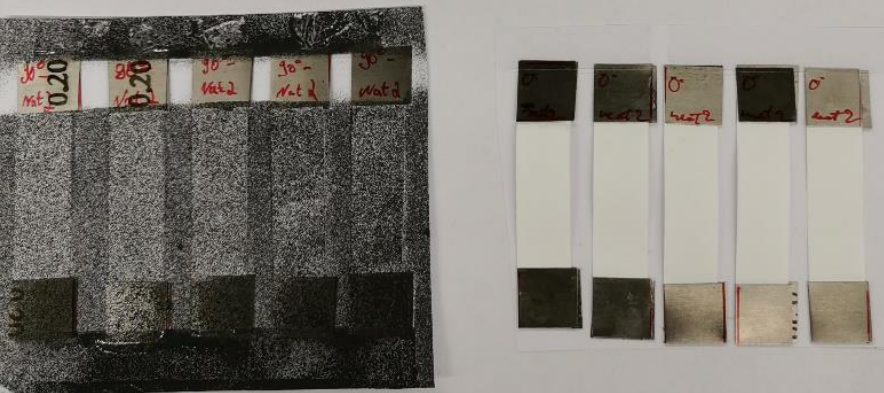
Figure 4. Set of prepared specimens ( right ) and gray sprayed pattern for the DIC system ( left ).